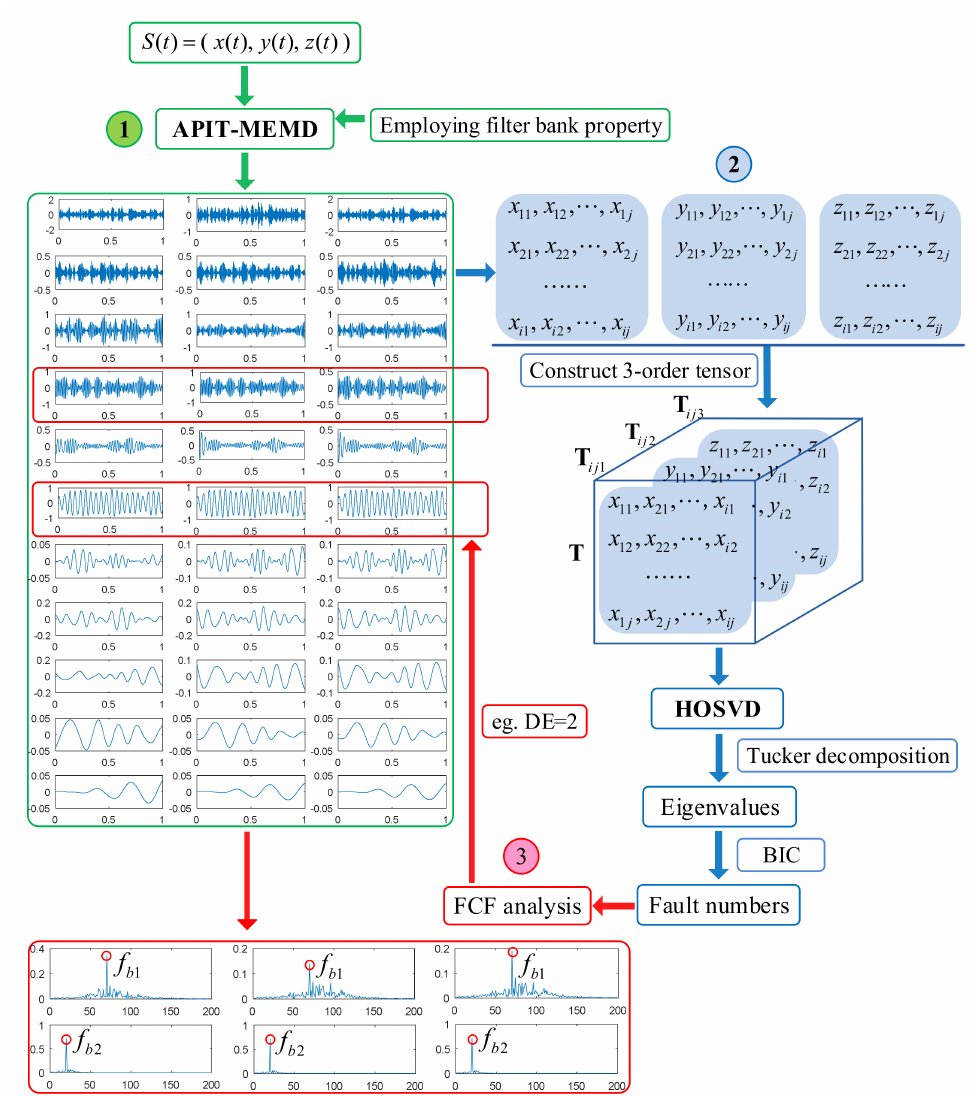
Figure 5. The proposed multi-fault diagnosis scheme of multivariate rolling bearing